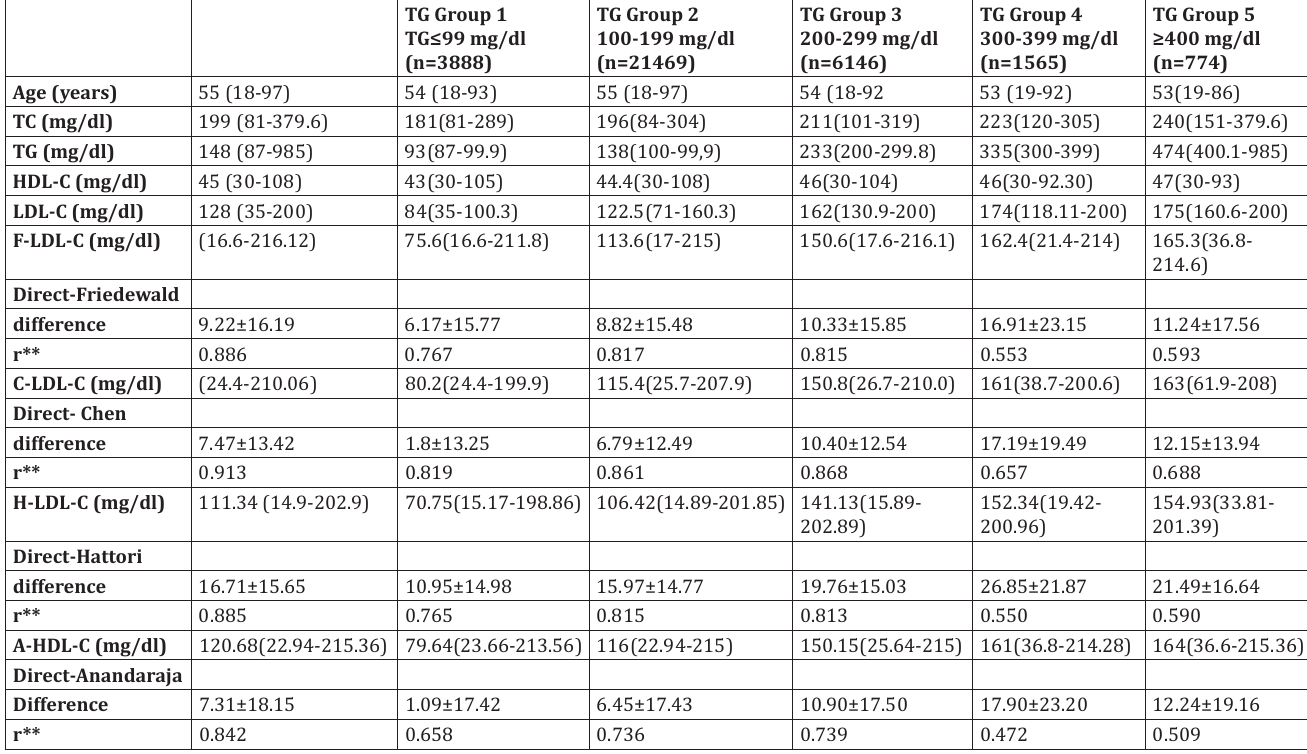
Biochemical parameters of the patients.